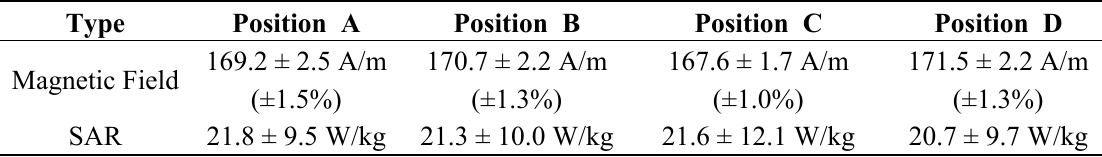
Figure 4. Photograph of the exposure system designed for magnetic resonant coupling WPT and cell culture dishes of 60-mm diameter inside of the conventional CO 2 incubator. Table 1. Magnetic fields and specific absorption rate (SAR) at each cell culture position calculated using the finite element method with a mesh size of 0.1 mm × 0.1 mm. The data presented are expressed as mean ± standard deviation (SD). Data from